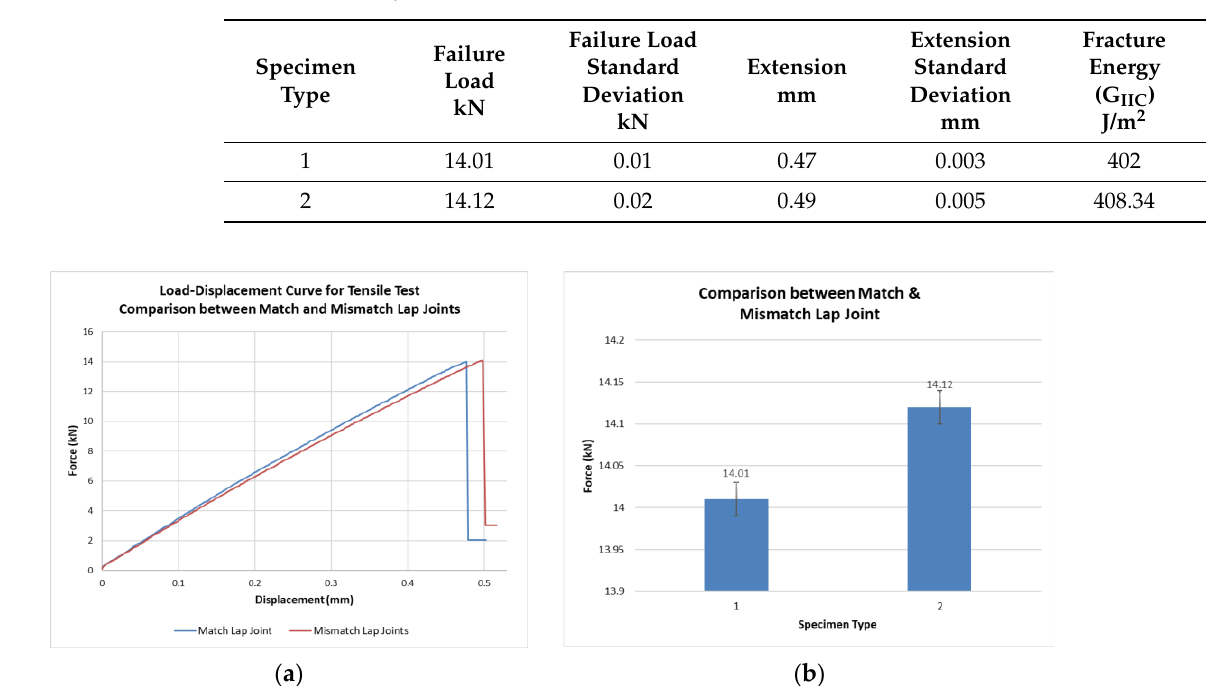
Figure 4. Comparison between match and mismatch lap joints: ( a ) load – displacement curve for tensile test; ( b ) failure loads along with error bars. Table 3. Summary of the tensile test results.